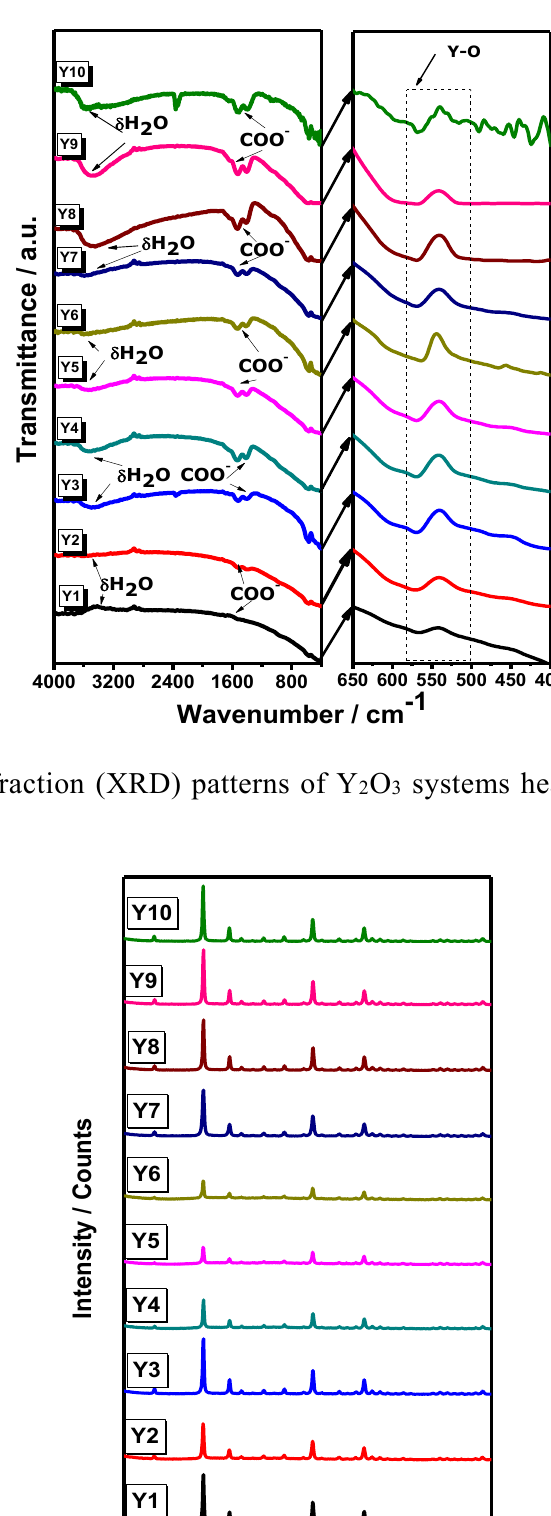
Figure 1. Fourier transform infrared spectroscopy (FTIR) spectra of Y 2 O 3 systems heat-treated from 700 °C to 900 °C.